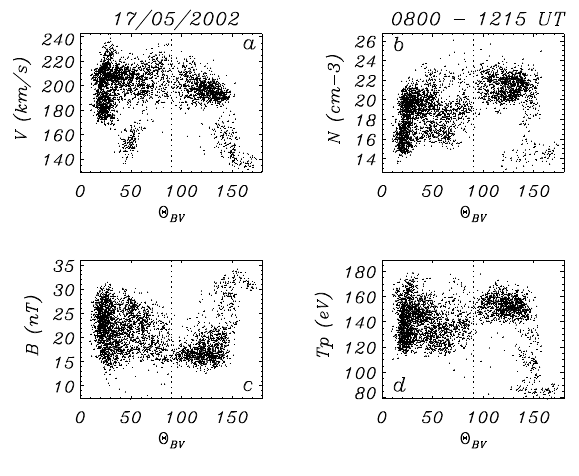
Figure11:Day17/05/2002,observationsbetween08:00and12:15UT,asfun tions